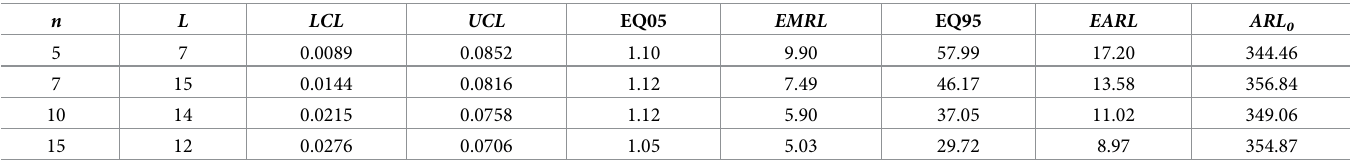
Table 8. Optimal charting parameters and the corresponding EQ05, EMRL , EQ95, EARL and ARL 0 for the EMRL -based side sensitive synthetic- γ chart for γ 0 = 0.05, n 2 {5,7,10,15} and ( τ min , τ max ) =